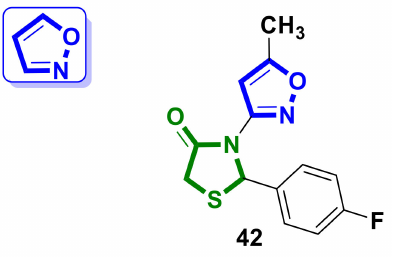
Figure 17. Structure of isoxazole–4-thiazolidinone hybrid